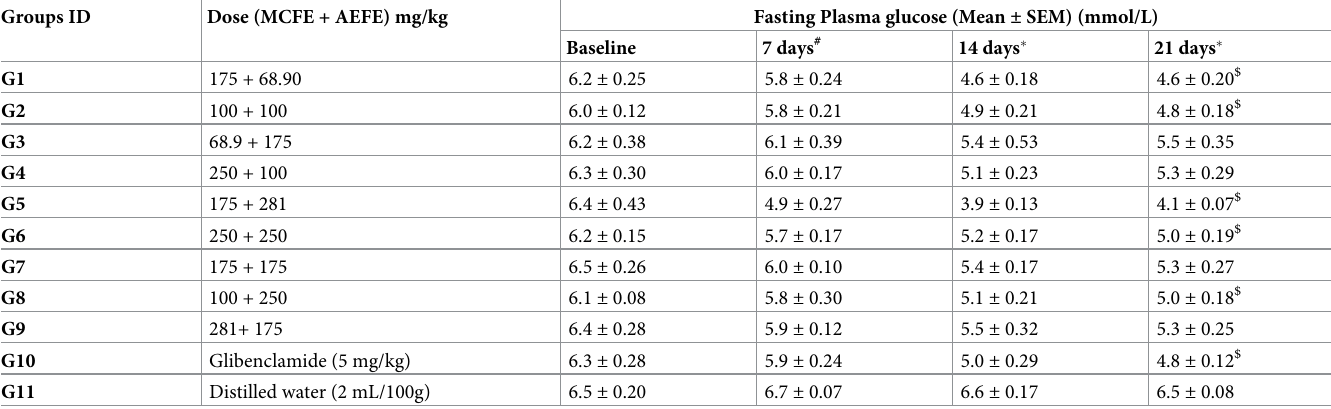
cated a significant difference in mean FPG levels of G1, G2, G5, G6, G8, and G10 compared to G11 p < 0.05. Among these groups, group G5 had a large mean difference at -2.4. Therefore, the dose of a binary mixture of fruit extracts given to G5 was considered in the subsequent for- mulation development.